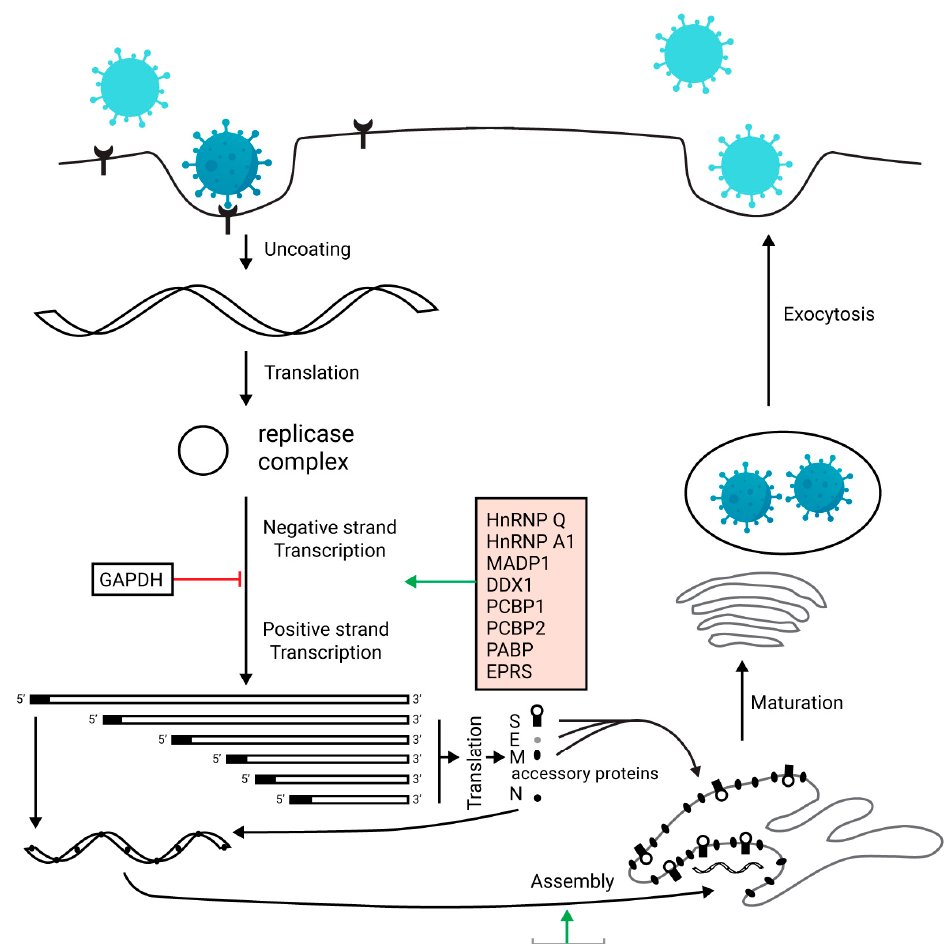
Figure 1. The life cycle of a coronavirus, modified, and used from Zhang et al. [27] with an open-access journal license. Upon entry to the host lungs, the CoV attaches to angiotensin-converting enzyme (ACE-2) receptors and releases its nuclear content into the cytoplasm. Translation of the RNA makes replicase complex, which results in the formation of transcripts of several proteins (named in pink box). Translation of these transcripts makes spike (S), envelope (E), membrane (M), nucleocapsid (N), and other accessory proteins. Assembly of these proteins produces a new virion that is matured and is released out of the cell to infect other cells.